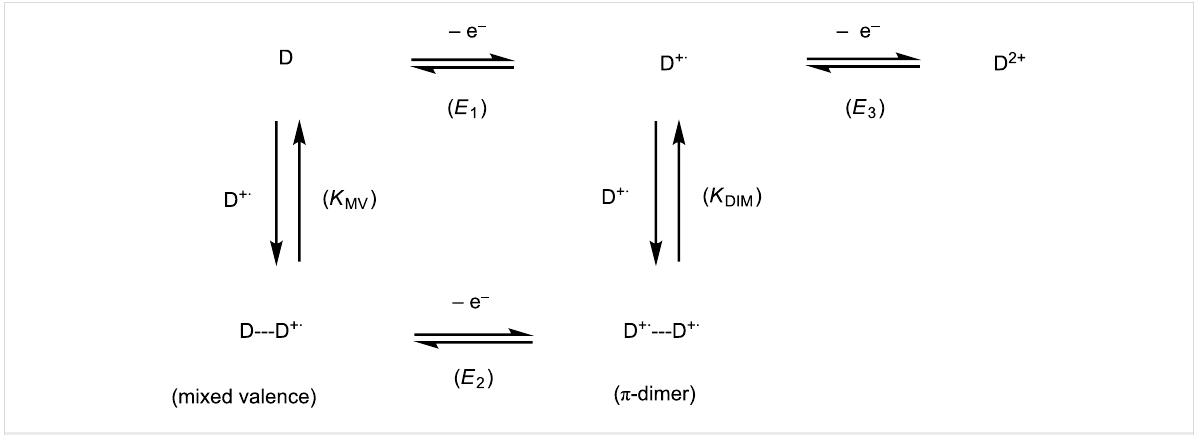
Scheme 4: Electrochemical mechanism used to simulate the CVs of molecular clips 1 , 2 and 3 .